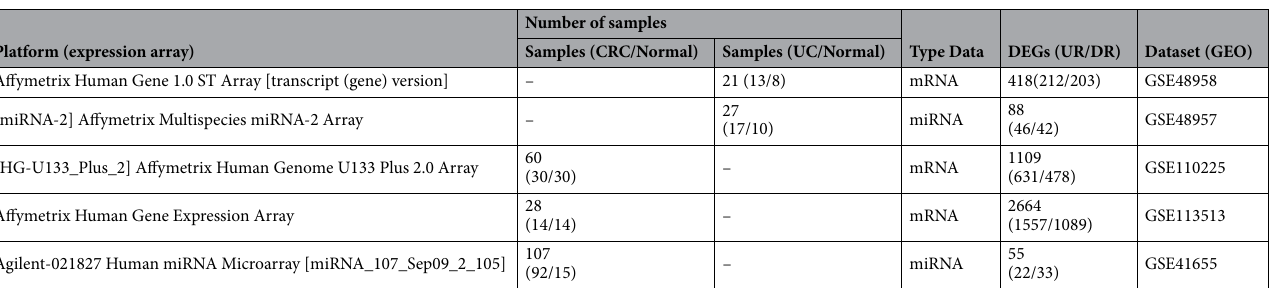
Table 1. Microarray dataset. CRC colorectal cancer, UC ulcerative colitis, DEGS differentially expressed genes, UR upregulated, DR downregulated.